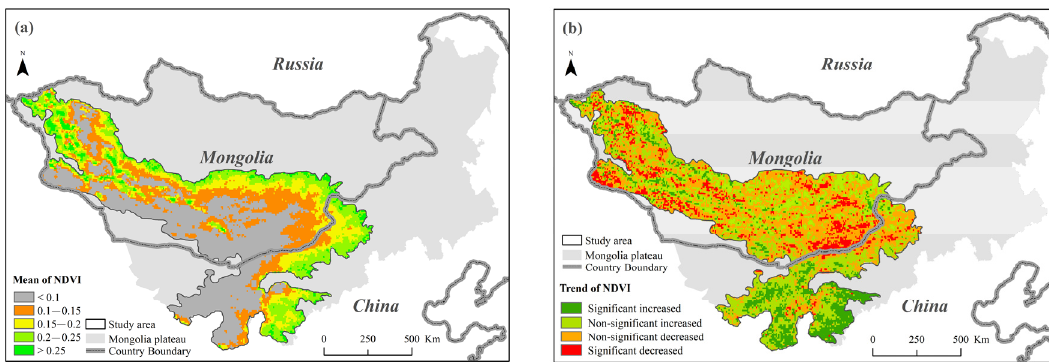
Figure 3. Spatial patterns ( a ) and trends ( b ) of the mean growing season NDVI during 1982–2015. To more intuitively show the dynamics of the changes in the spatial pattern of green- ness, we analyzed the spatial distribution of vegetation coverage areas (annual mean growing season mean NDVI ≥ 0.1) and non-vegetation areas (annual mean growing season NDVI < 0.1) in the study area for 1982, 1994, 2005, and 2015 (Figure 4). In 1982, the vegetation coverage areas were distributed in the northwest, north, as well as in the northeast, and southeast of the study area, accounting for 59.61% of the total area (Figure 4a). The vegetation coverage area increased significantly to 74.24% in 1994 and decreased to 54.14% in 2005 (Figure 4b,c). The decreasing vegetation coverage area was mainly located in the central study area during the ten years between these data points. The vegetation coverage area in 2005 then increased again to 69.49% in 2015, mainly because the existing vegetation increased in abundance, enough to go over the 0.10 threshold in the central and southern areas during this period (Figure 4d).